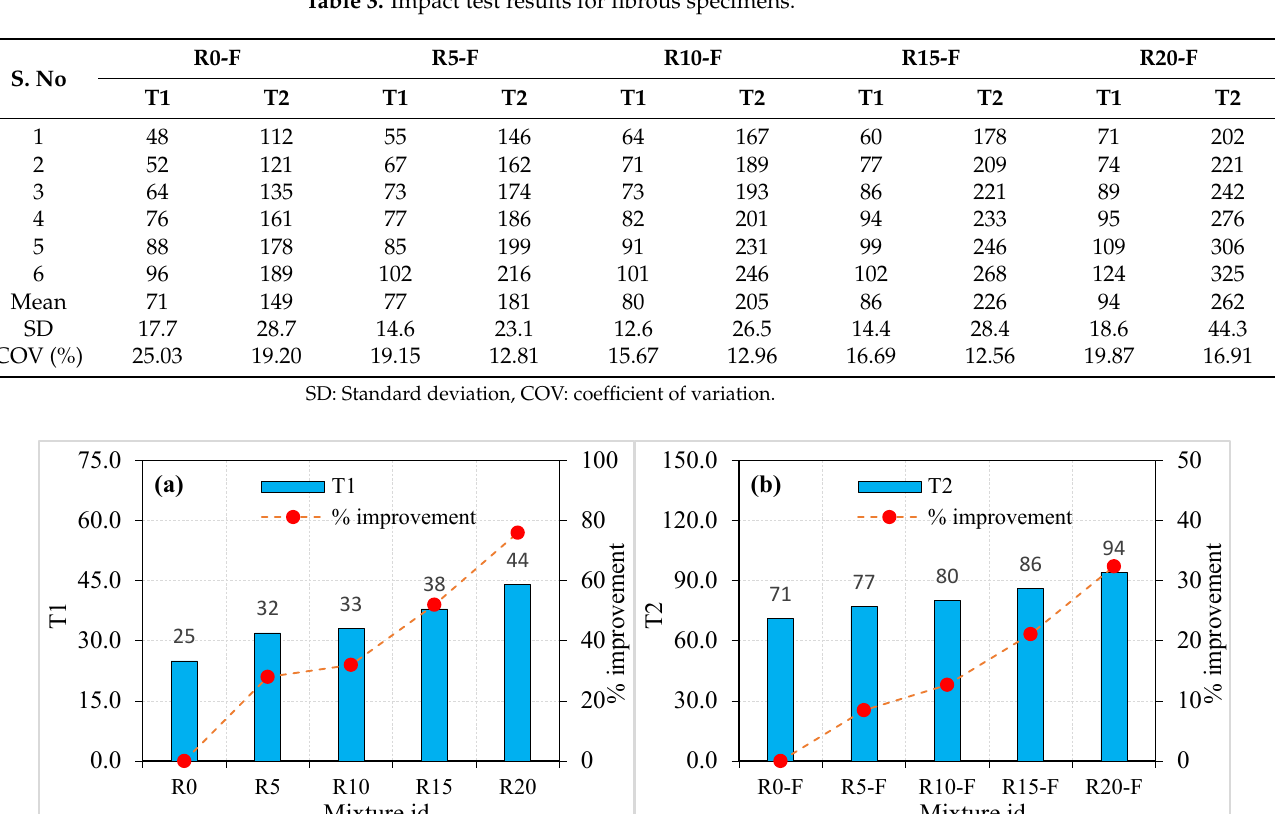
Table 3. Impact test results for fibrous specimens.